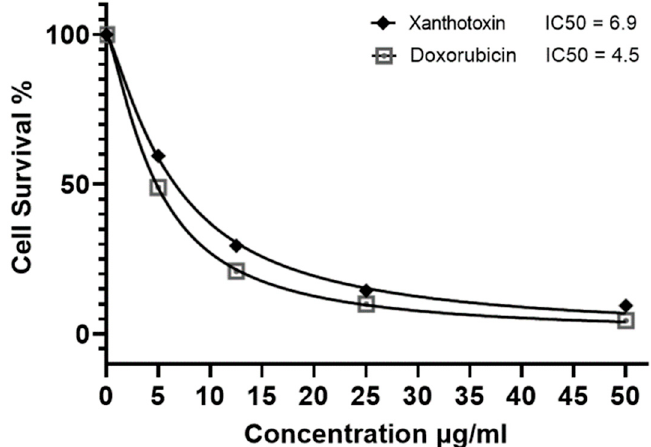
Figure 3. IC 50 µ g/mL of the major compound xanthotoxin isolated from Ammi majus fruit methanol Figure 3. IC 50 µg/mL of the major compound xanthotoxin isolated from Ammi majus fruit methanol extract against HepG2 cells, seeded at 2 × 10 3 cells for 48 h in complete extract against HepG2 cells, seeded at 2 × 10 3 cells for 48 h in complete DMEM.